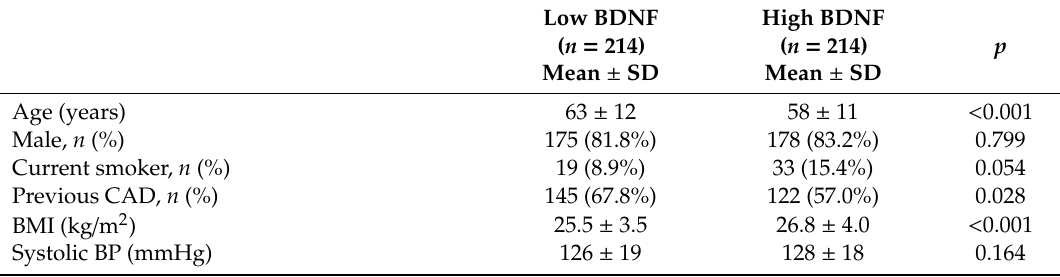
Table 3. The characteristics of patients with high AUC of BDNF and low AUC of BDNF at baseline Model 4 = AUC of BDNF + FRS, CI = confidence interval.